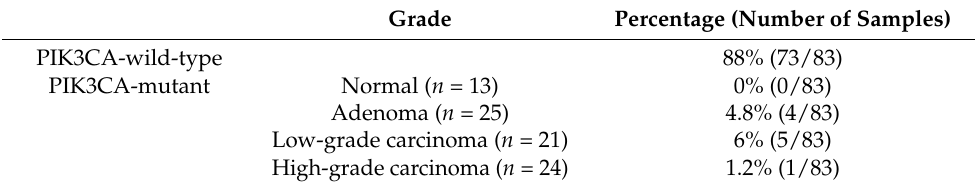
Figure 1. Sequence analysis for exon 20 of PIK3CA in canine mammary tumors. ( A ) Wild-type sequence of PIK3CA exon 20, and ( B ) mutant allele for missense mutation of PIK3CA (c.3140A > G) is detected (arrow). Table 2. PIK3CA H1047R mutation in each histological